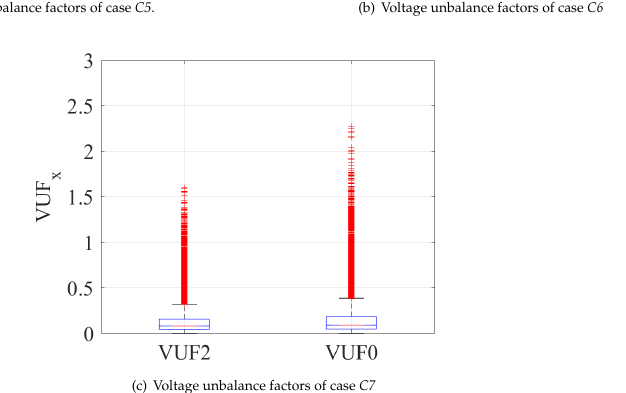
Figure 10. Concatenated VUFs results of the entire LV grid when cases C5 to C7 are